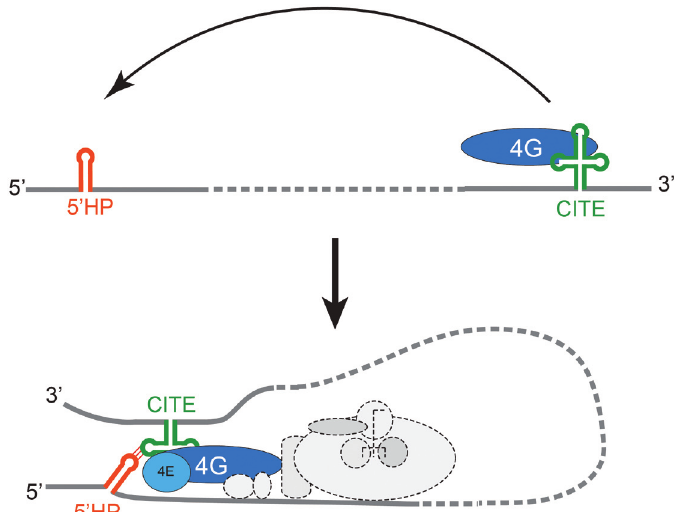
Figure 3. A strategy used by some CITE RNAs. (Top) The CITE element (green) is located in the 3 ′ untranslated region where it can bind a eukaryotic initiation factor (eIF) (in this case, eIF4G associated with eIF4E, both in blue). (Bottom) Base-pairing between a hairpin (HP) in the CITE and a HP near the 5 ′ end (orange) results in delivery of the factor to the 5 ′ end, where it can serve in translation initiation along with the 43S complex (shown in dashed gray). Other CITEs use diverse strategies. CITE, cap-independent translation